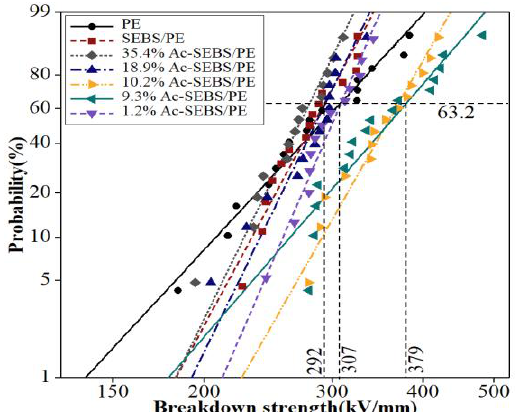
Figure 6. Weibull plots of the DC breakdown strength of PE, SEBS/PE, and Ac-SEBS/PE.